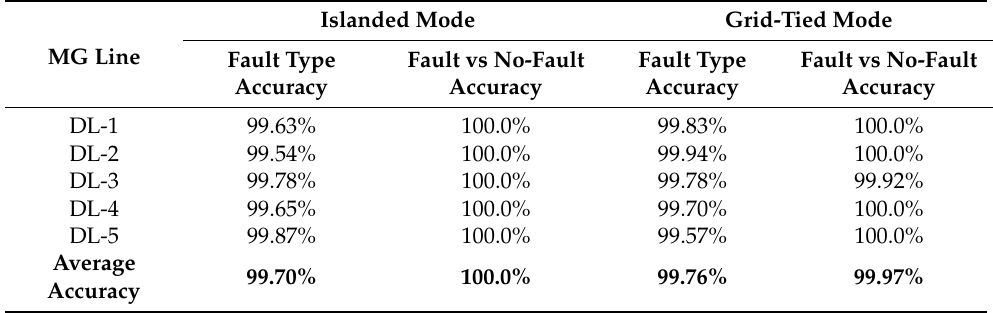
Table 3. FTD unit accuracy of the proposed FIPS on the IEC MG system.